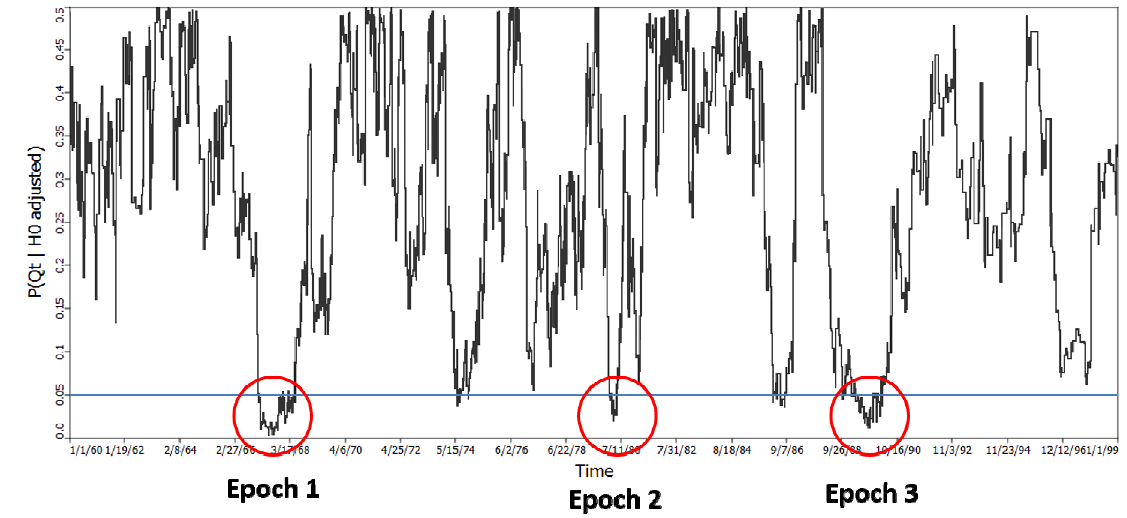
Figure 6. The probability of the (cid:1843) test for spatial clustering of cases relative to controls (cid:3047) through time. This test assesses whether and when there is spatial clustering of cases when all of the cases and controls are considered simultaneously at a given time t . p = 0.05 is shown by the blue horizontal line. The count of the number of observations below this line is (cid:1829)(cid:1827)(cid:1844)(cid:1830)(cid:3435)(cid:1843) ∗ (cid:3562) (cid:3439) = 122 and is highly significant ( p = (cid:3047)